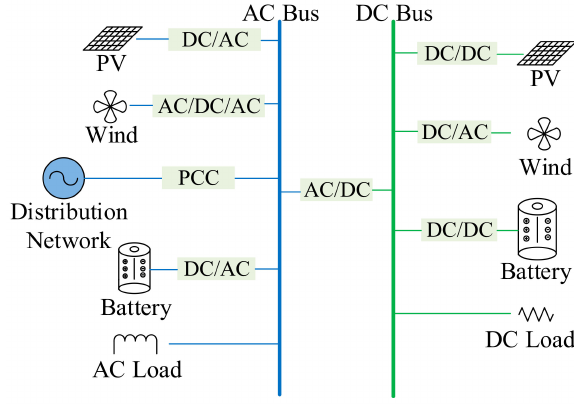
Figure 2. AC/DC hybrid microgrid typical